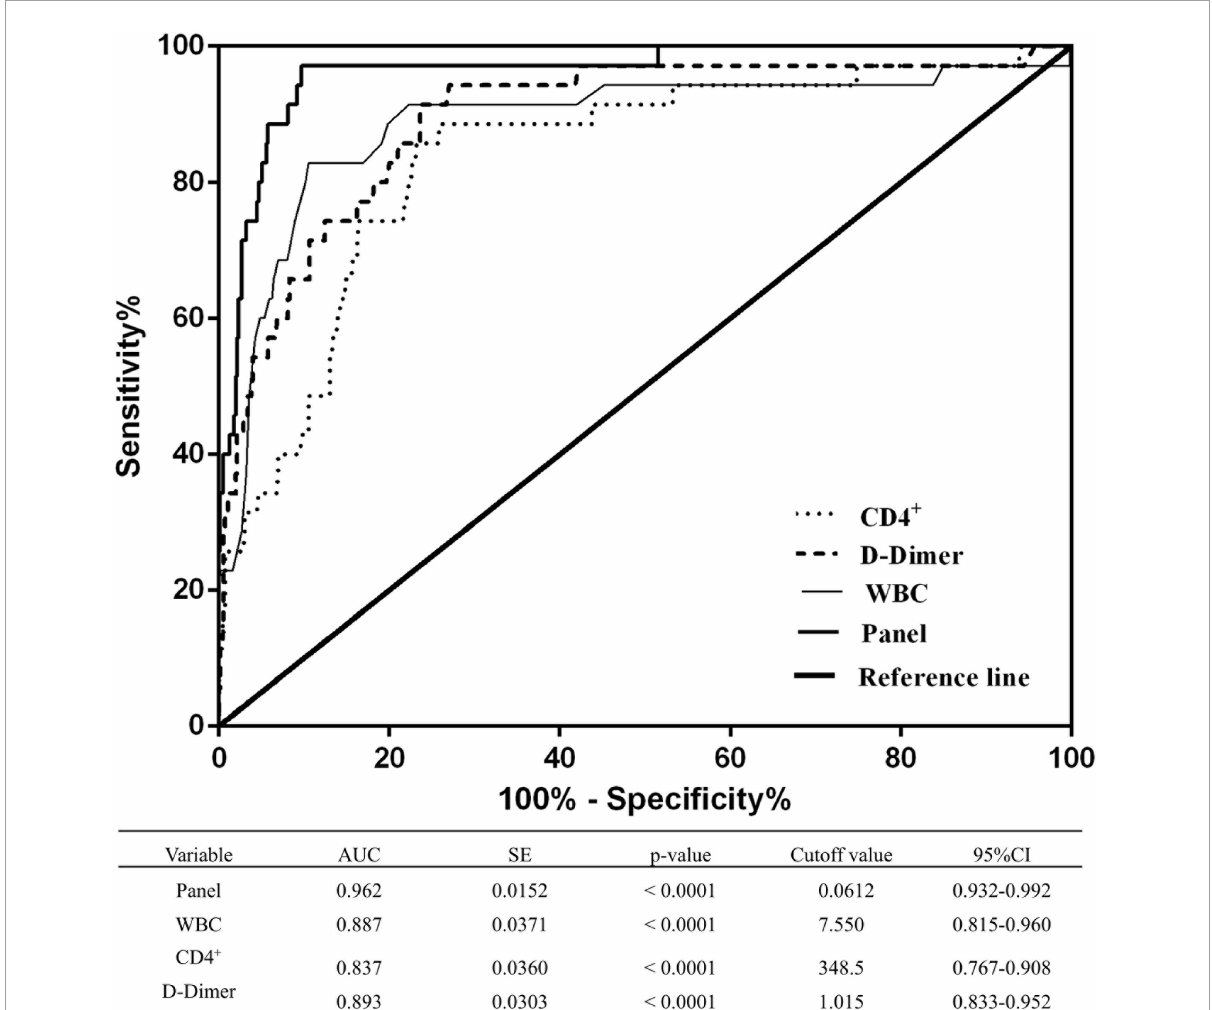
FIGURE3 Receiver operating characteristic curves of WBCs, CD4 + T cells, D-dimer levels, and the combined panel for distinguishing the severe/critical state from the mild/moderate state. An analysis of the ROC curves for WBCs, CD4 + T cells, D-dimer levels, and the combined panel was used to differentiate the severe/critical state from the mild/moderate state. Areas under the curves were compared. SE, standard error; CI, confidence